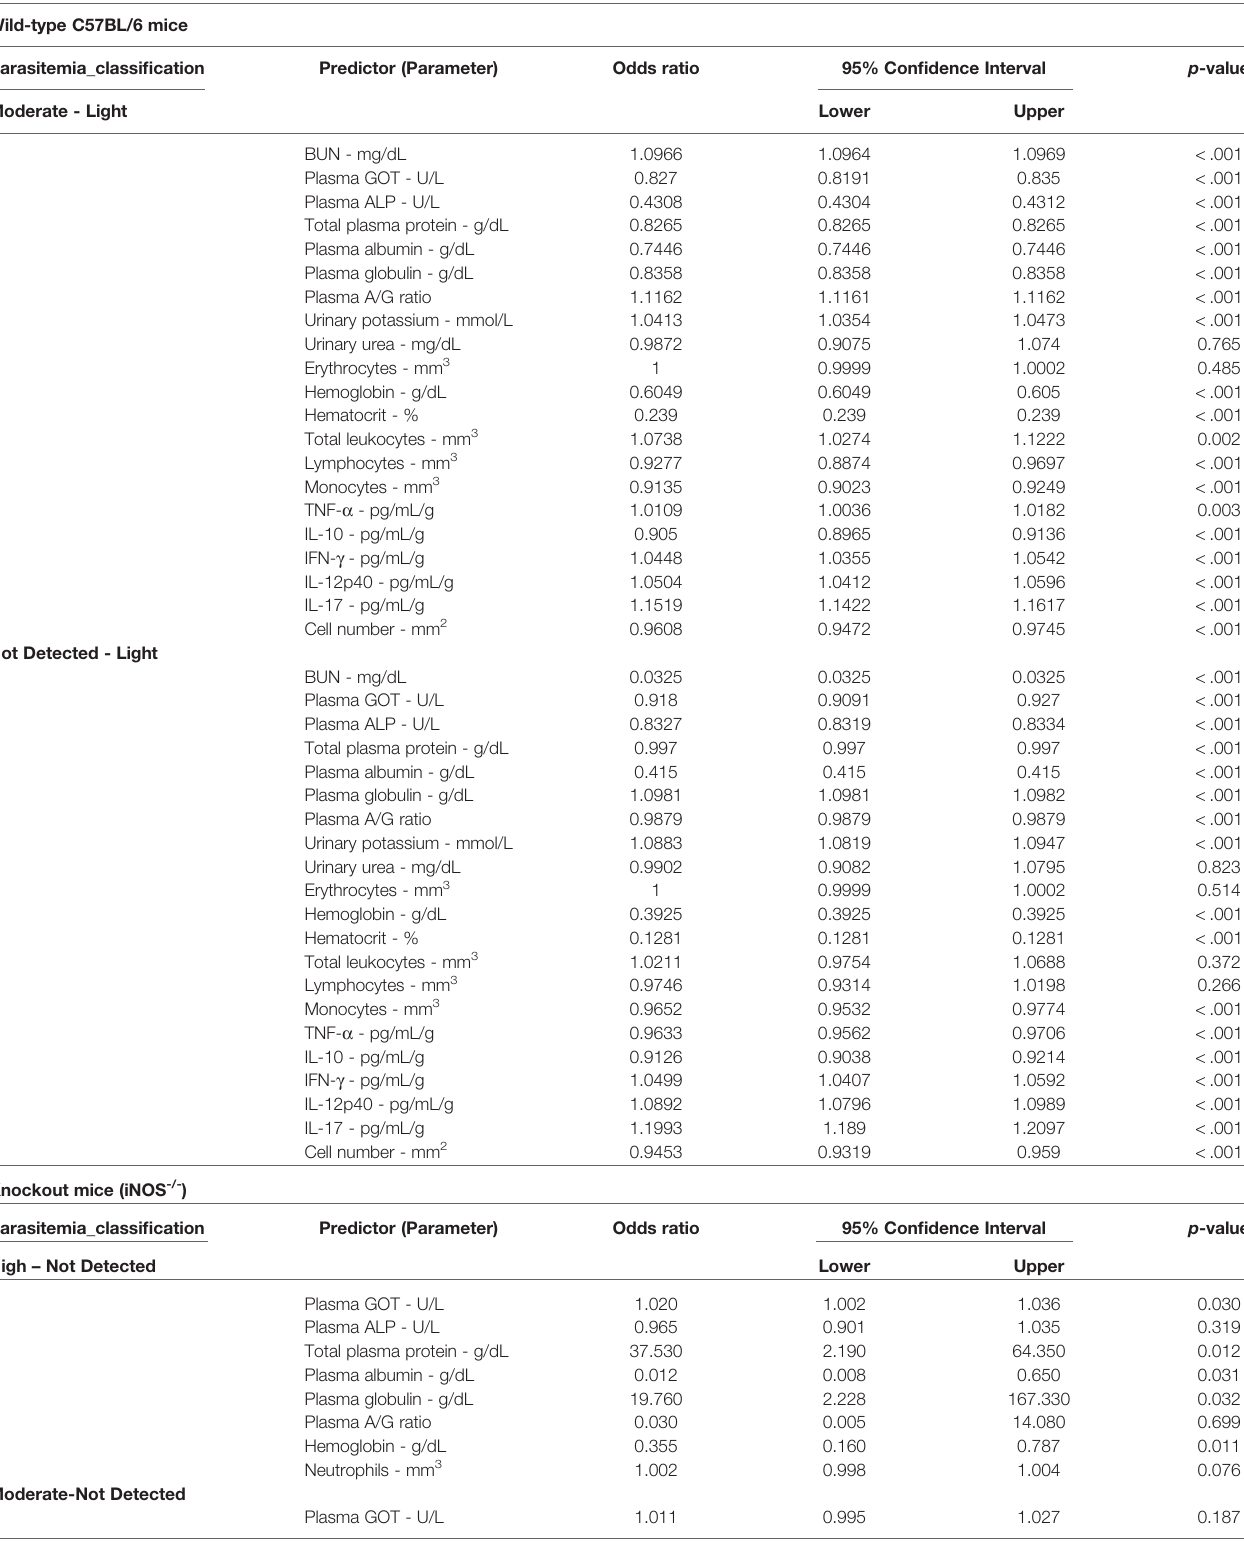
TABLE 2 | Estimation of parameters in a multinomial logistic regression model for the classi fi cation of Trypanosoma cruzi (strain “ Y ” ) load in the blood (undetected, light, moderate, and high) in wild-type C57BL/6 and knockout (iNOS -/- )